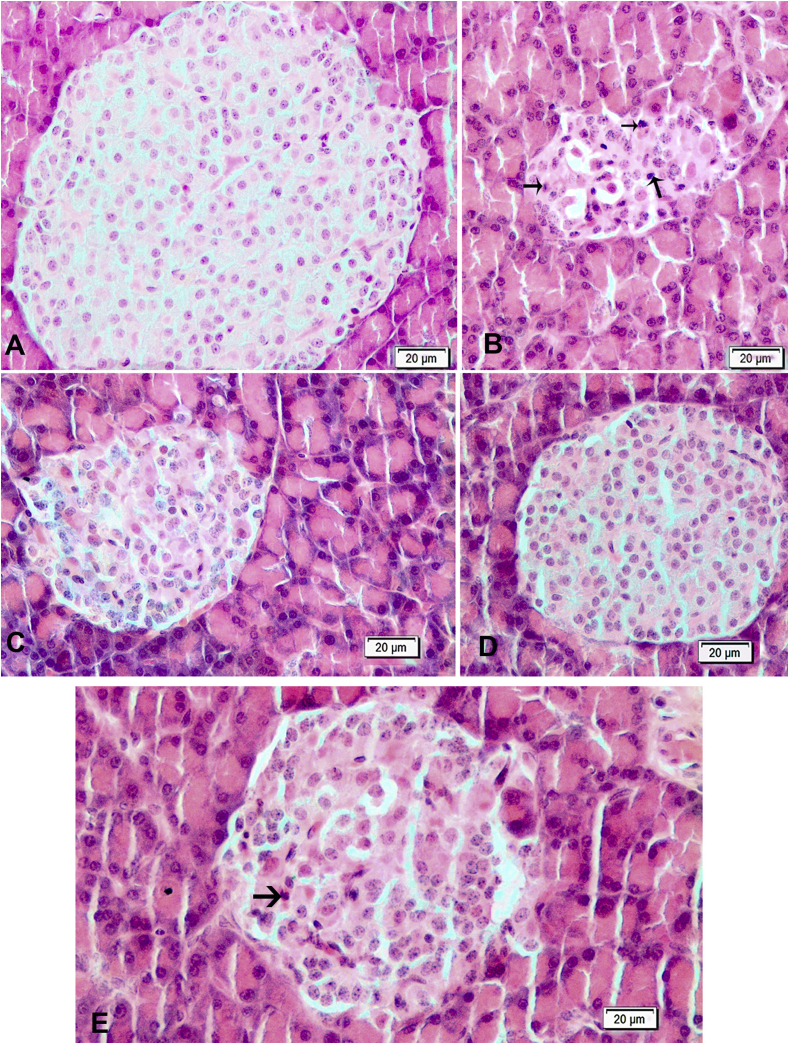
Hematoxylin and eosin-stained sections of pancreas. A) Control group: Normal histological appearance of islets of Langerhans. B) Diabetic group: Note that islets of Langerhans is atrophic, and there are hydropic degeneration and necrosis (arrows) of some cells of islets of Langerhans. C) Diabetic + L. nobilis treated group: Almost normal histological appearance of islets of Langerhans. D)L. nobilis group: Normal histological appearance of pancreas. E) Diabetic + Acarbose treated group: Showing slight hydropic degeneration and a few necrotic cells of islets of Langerhans. Bar = 20 μm.